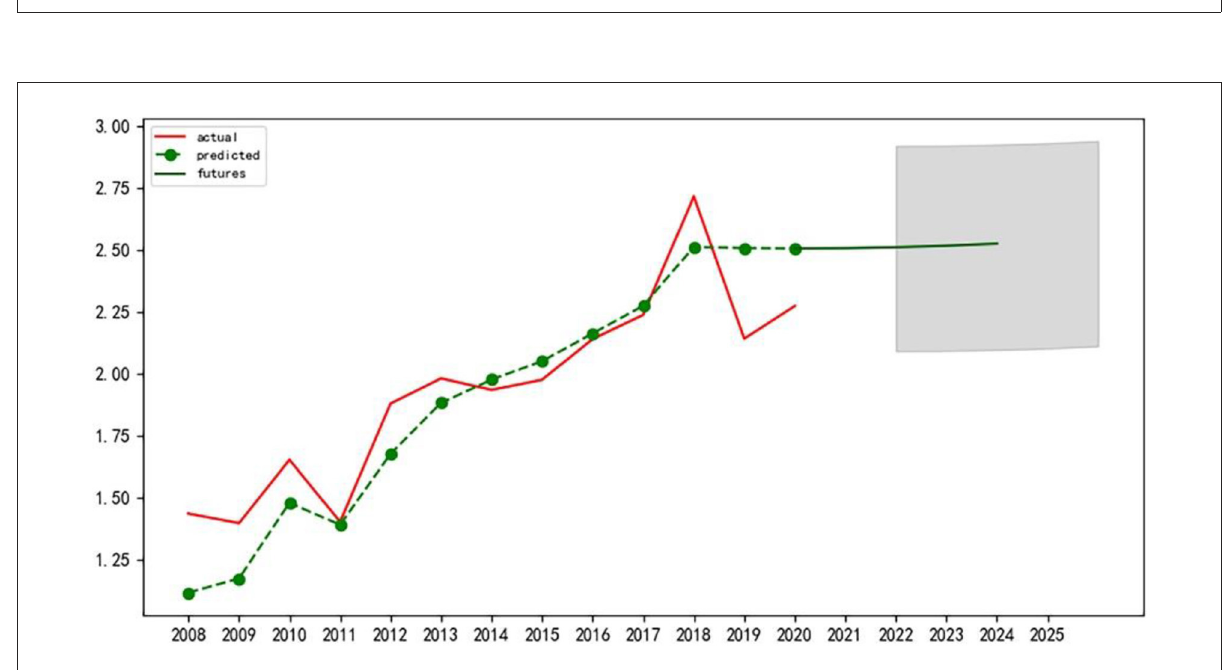
FIGURE3 Prediction of variable eigenvalues of sustainable development level of APSC in Liaoning